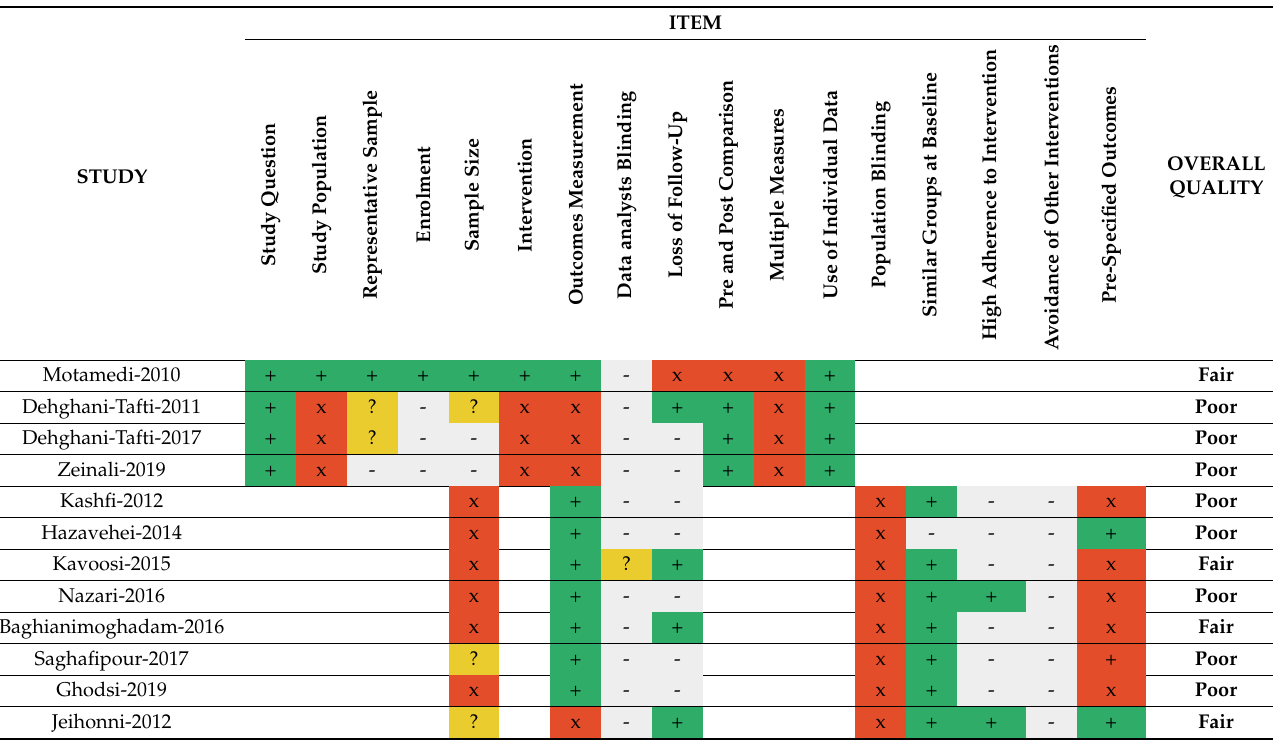
Table 5. Quality appraisal of pre and post-intervention and quasi-experimental